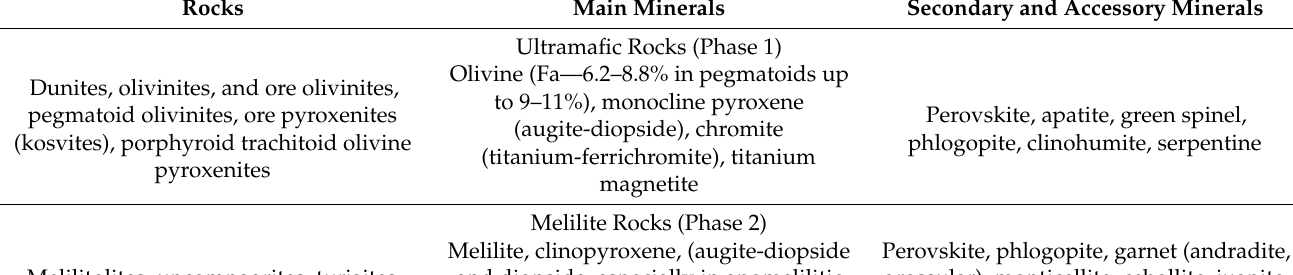
Table 1. Mineral composition of the rocks of the Maimecha-Kotuy alkaline-ultramafic magmatic complex [14]. Rocks